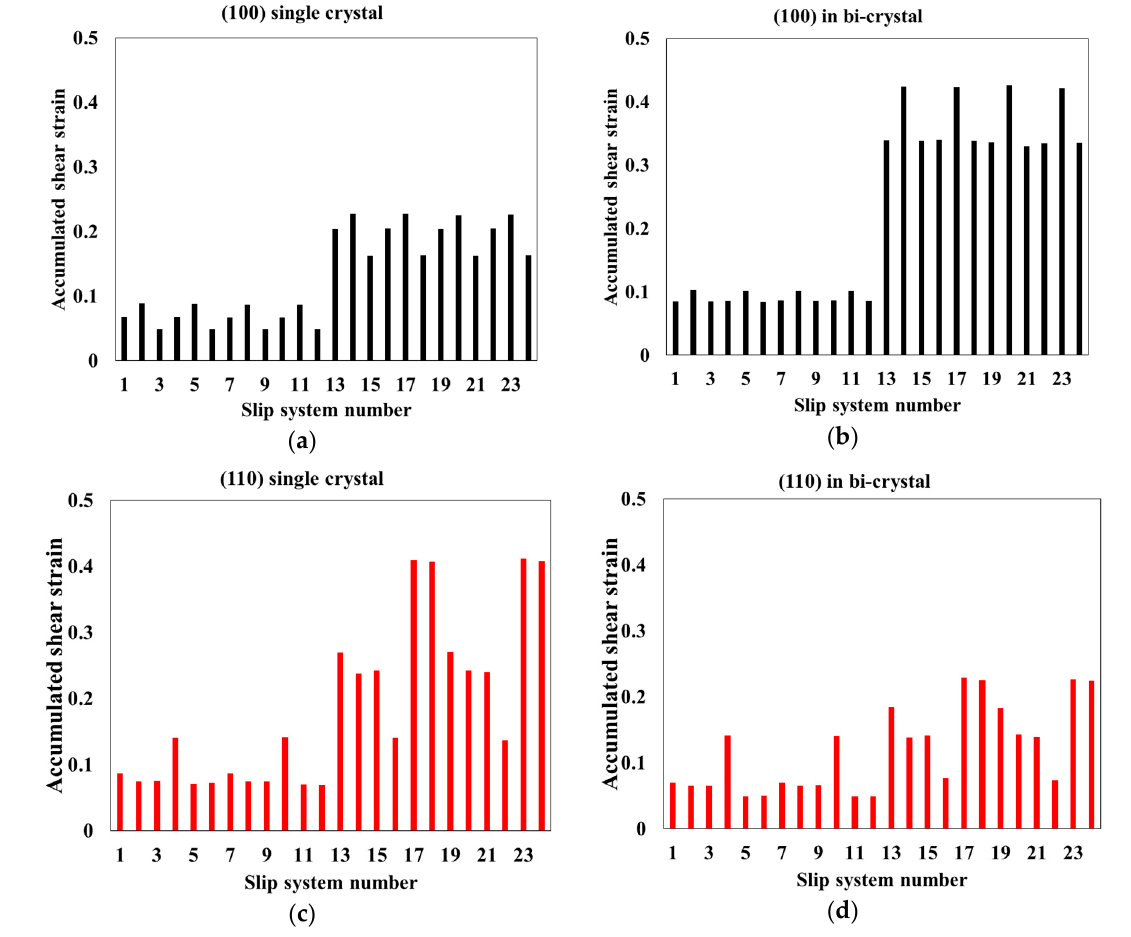
Figure 10. Average accumulated shear on the slip systems at ( a ) (100) single crystal, ( b ) (100) portion in (110)-(100) bi-crystal, ( c ) (110) single crystal and ( d ) (110) portion in the bi-crystal.